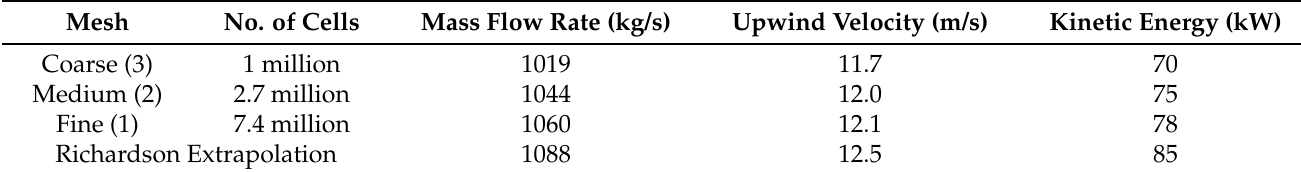
Table 5. Grid convergence study for SCPP without